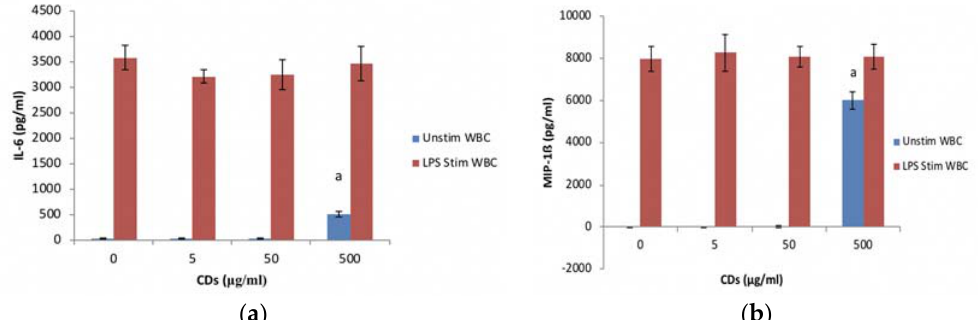
Figure 5. The inflammatory biomarker expression levels of whole blood cell cultures exposed to CDs. Nanoparticles (NPs) in the absence or presence of LPS: ( a ) IL ‐ 6 expression levels and ( b ) MIP ‐ 1 β expression levels. Data represents mean ± SD with n = 4. Bars marked with letters indicate significant differences ( p < 0.01). Significance demarcated by: a—significantly different compared ( p < 0.002) to 0 μ g/mL CD control.